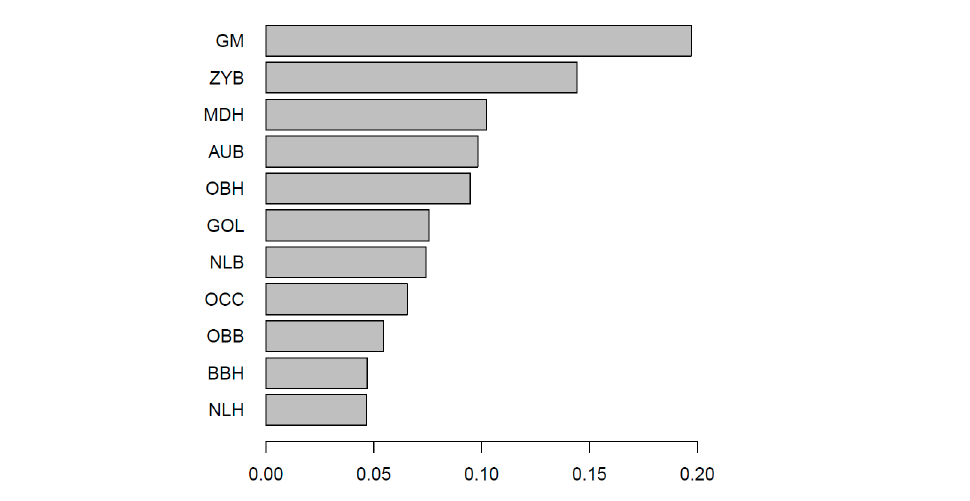
Figure 8. Receiver operating characteristic (ROC) curve showing the observed performance (com- pared to the uninformative case—random prediction—and a perfect estimation, where all observa- tions were correctly assigned to their true class.